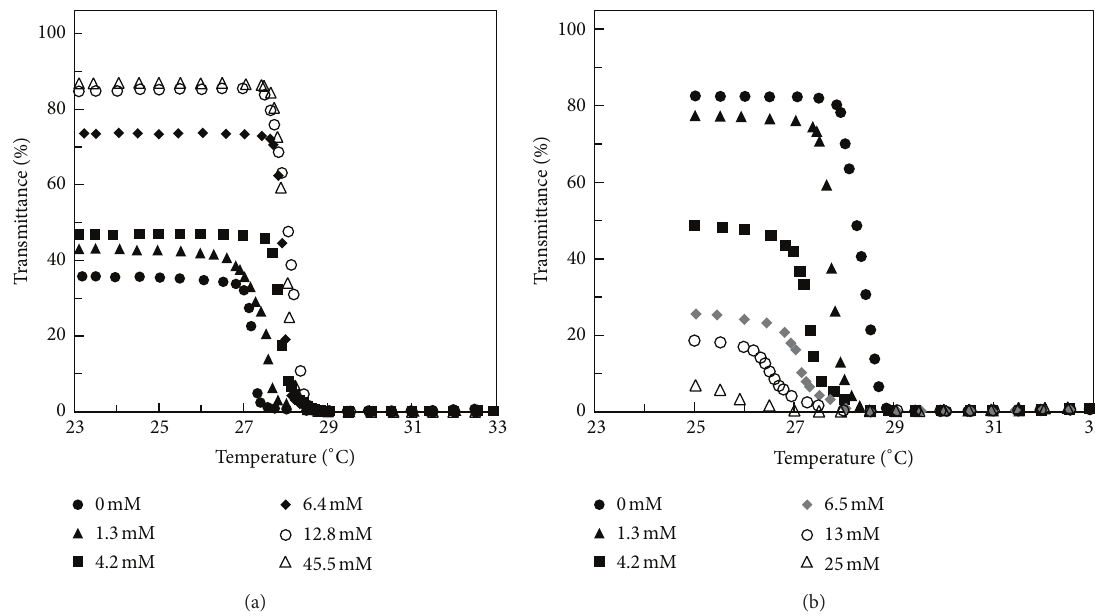
Figure 5: (a) Transmittance change of 10mg/mL solutions of the PNIPAAm- block -PTEMPOMA- block -PNIPAAm ( 3 󸀠 ) in 0.1 M Na 2 SO 4 aq in the presence of various amounts of L-ascorbic acid 0–45.5 mM and (b) transmittance change of the resulting solutions of the corresponding reduced copolymer in the presence of various amounts of K 3 [Fe(CN) 6 ].